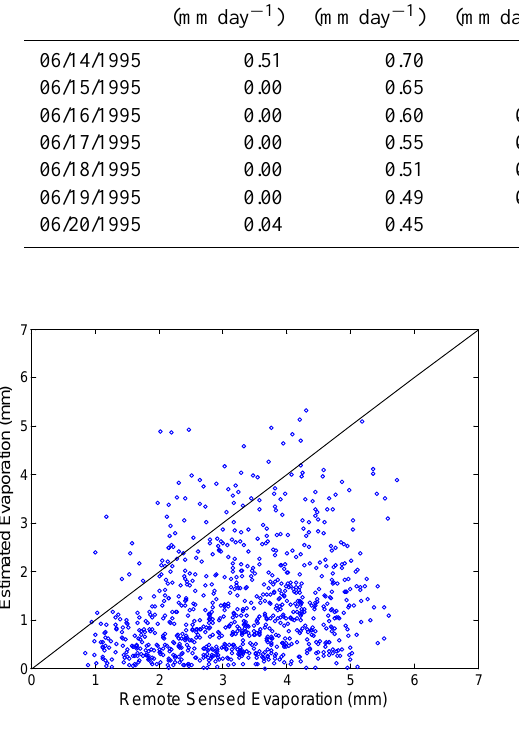
Fig. 3. Comparison between estimated evaporation from recession analysis and evaporation from remotely sensed data.